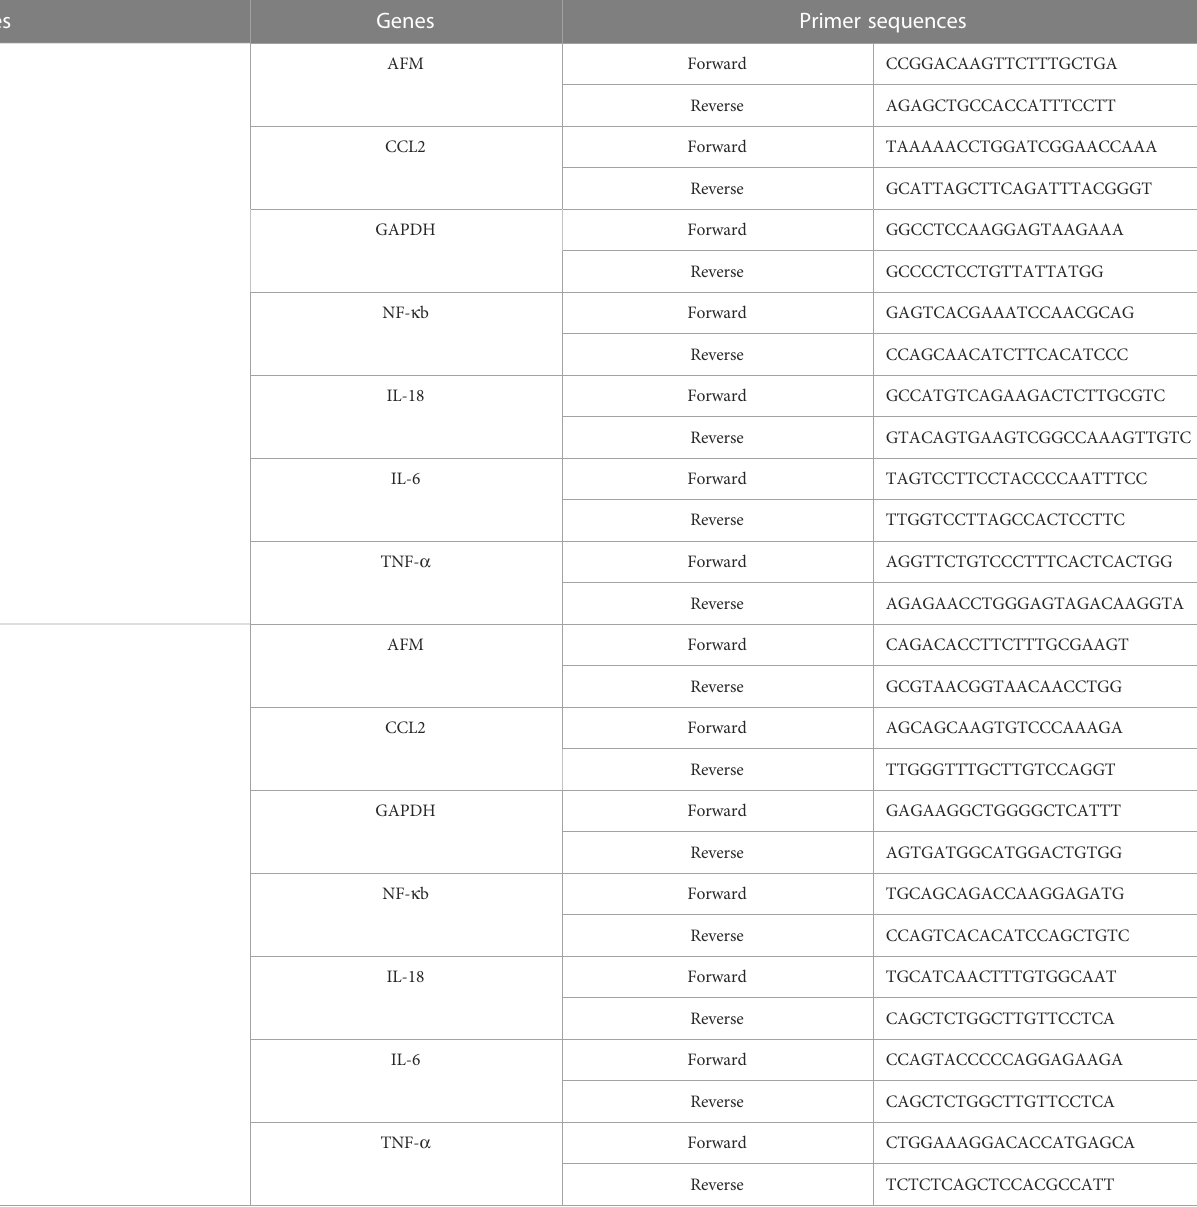
TABLE 1 Primers for real time-quantitative PCR. Species Genes Primer